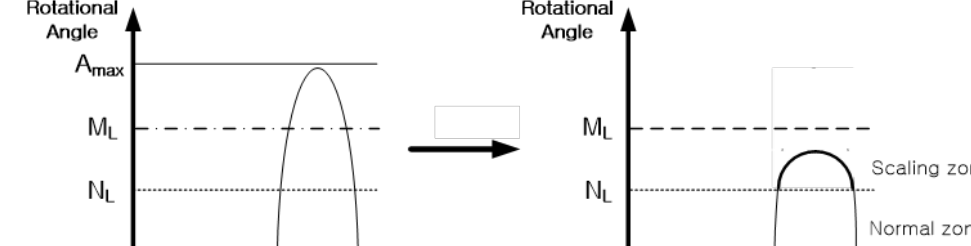
Figure 2. Structure of the proposed washout algorithm.